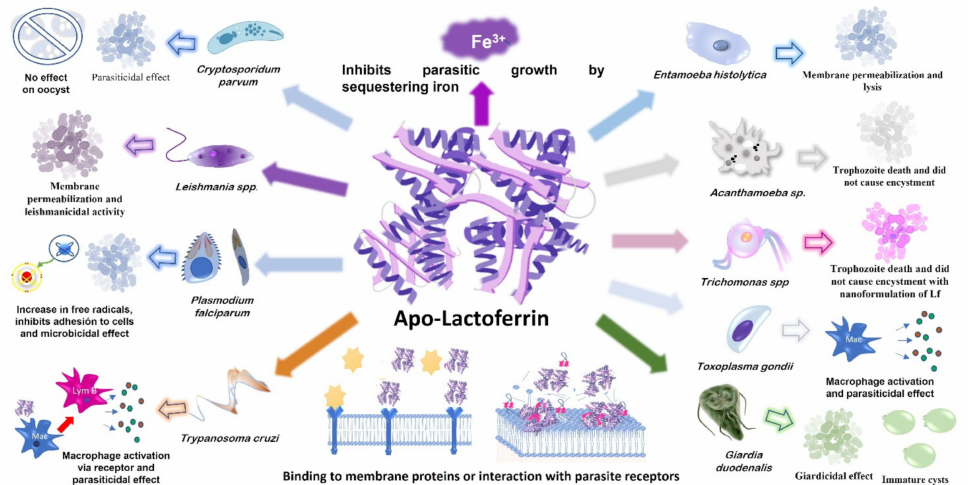
Figure 1. Effect of apo-lactoferrin on pathogenic protozoa. The activity of apo-Lf is to inhibit the growth of infectious agents through iron chelation, pathogen death by membrane destabilization, or parasite neutralization by binding to its receptor. In addition, the activity exerted by apo-Lf is also specified in each